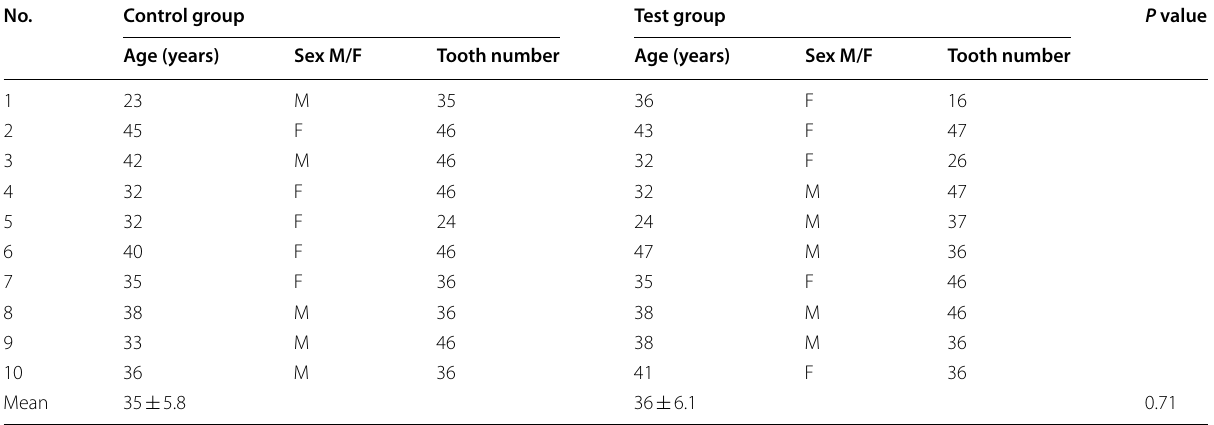
Age distribution of the patients reveals no significant differences as evident from P value (0.71)